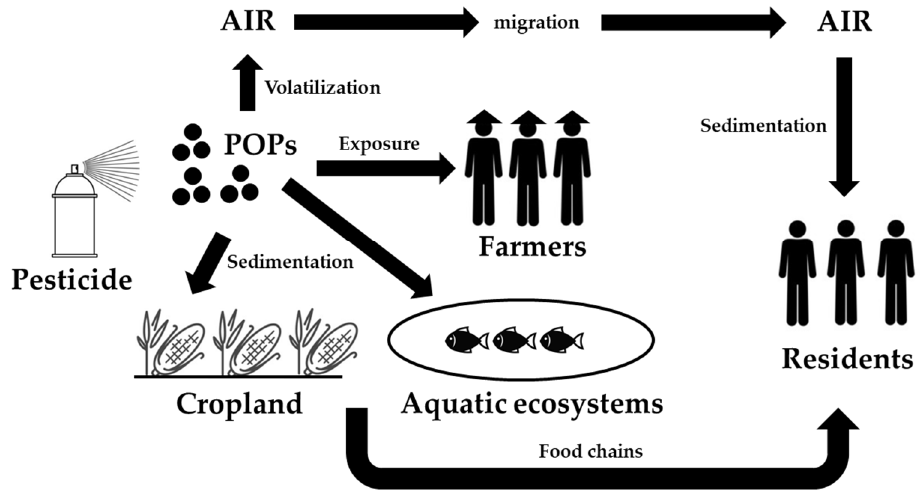
Figure 3. Pesticides can influence the environment and human health in different ways.